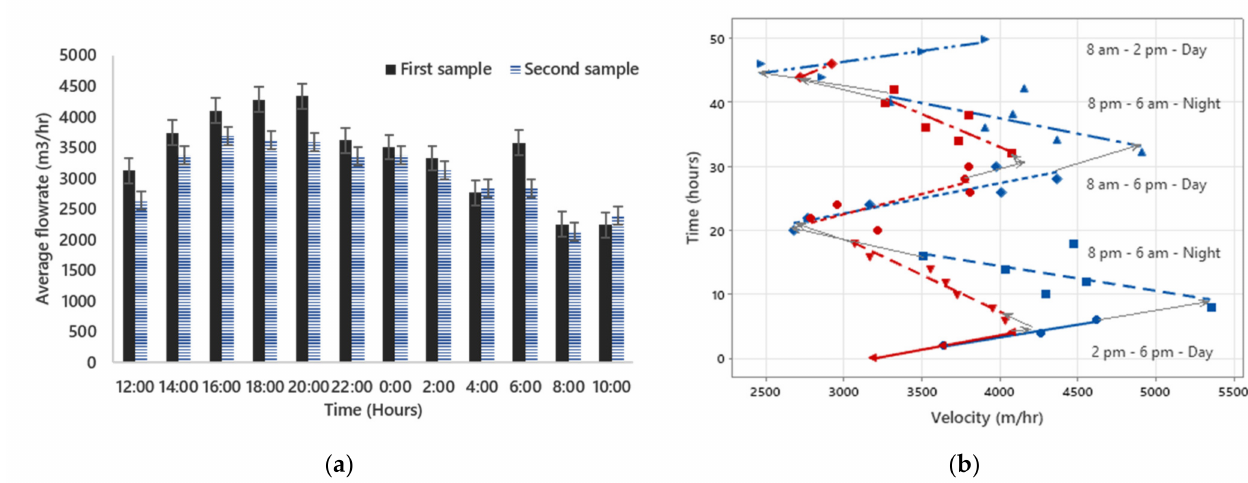
Figure 1. Variation of wastewater quantity throughout the sampling event. ( a ) Average flowrate during the first and second sampling events. ( b ) Scatterplot showing the velocity of wastewater at different times of the